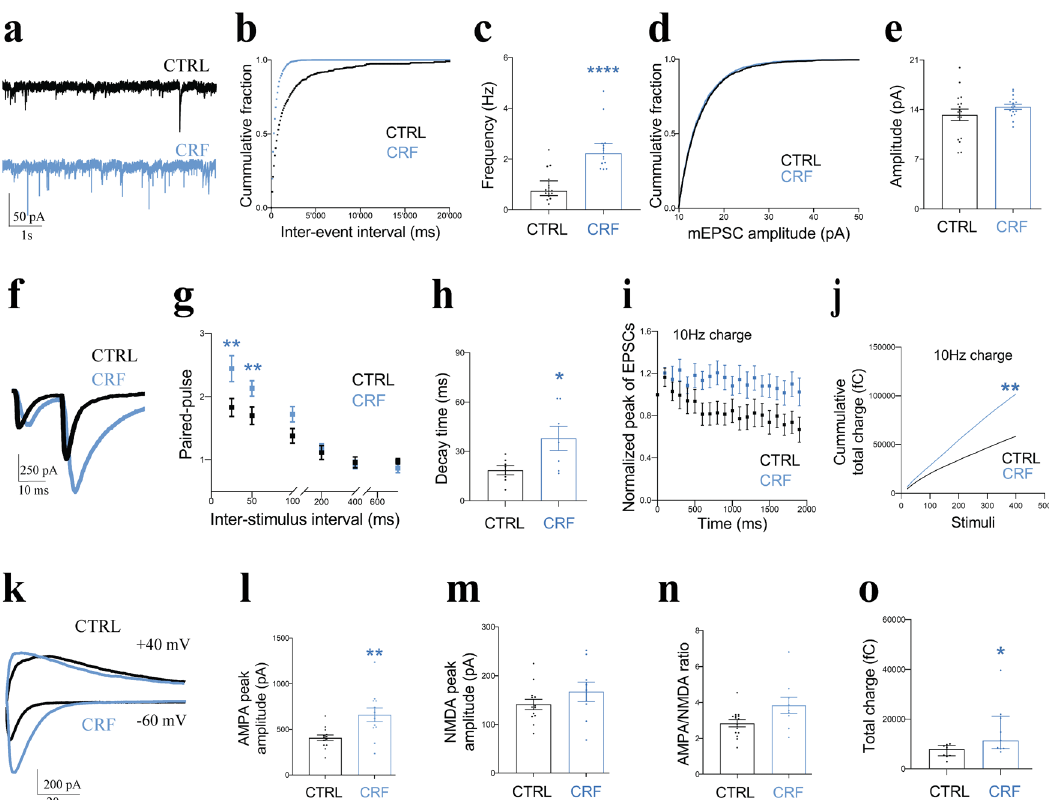
Fig. 3 Acute CRF treatment increases synaptic input and synaptic reliability. a mEPSCs recorded in CA1 PCs in control (black) and 20 min after 100 nM CRF treatment (blue). b, c CRF increased mEPSCs frequency (shown as median with IQR. CTRL: N = 3 animals, n = 16 cells; CRF: N = 3, n = 15; Mann – Whitney test (U = 15). **** p < 0.0001), d, e but not amplitude (shown as mean ± SEM. CTRL: N = 3, n = 17; CRF: N = 4, n = 16; unpaired t -test (t = 1.267, df = 31). P = 0.2147). f Stimulation of SCs resulting paired-pulse input in recorded CA1 PCs under control (black) and CRF pretreated conditions (blue). g, h CRF increased amplitude, increased paired-pulse facilitation with 25 and 50 ms inter-stimulation intervals ( g , shown as mean ± SEM. CTRL: N = 4, n = 15; CRF: N = 4, n = 16; unpaired t -test (for 25 ms; t = 3.406 and df = 31, for 50 ms; t = 2.835 and df = 31). ** p < 0.01), and the decay time ( h , shown as mean ± SEM. CTRL: N = 4, n = 15; CRF N = 4, n = 16; unpaired t -test (t = 3.738 and df = 31). *** p < 0.001) of the second evoked EPSC. i, j Normalized EPSC amplitude i and j cumulative total charge released during